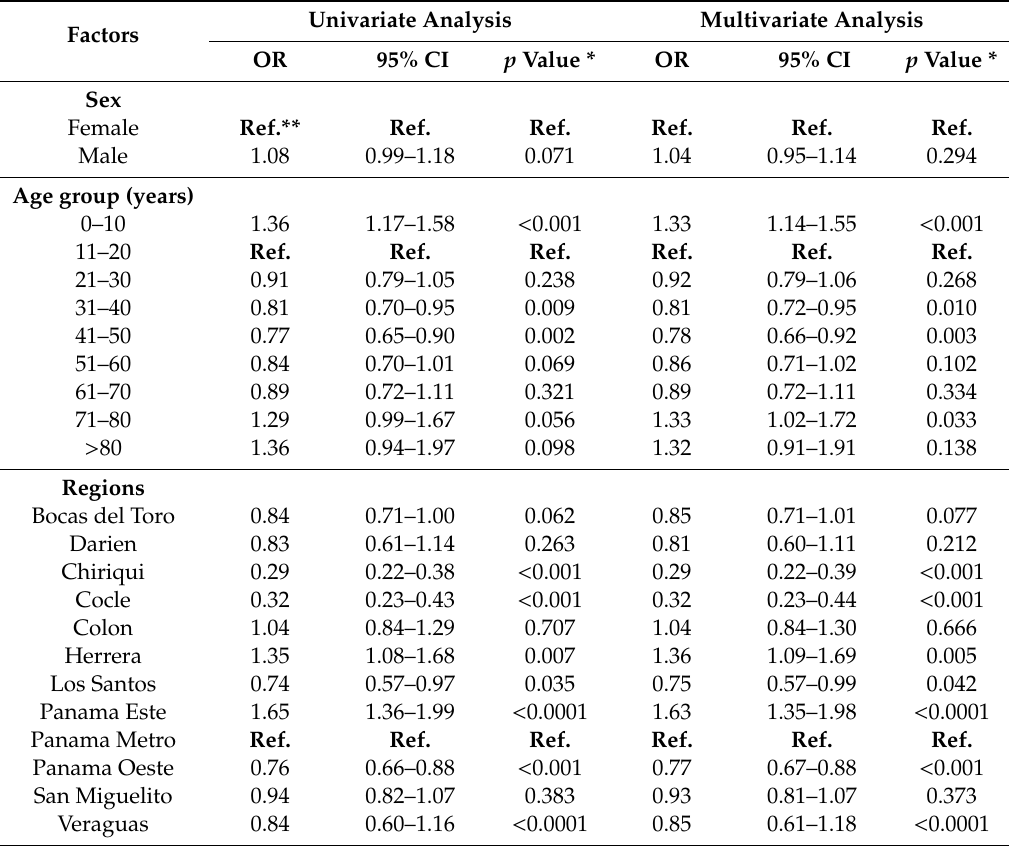
Table 2. Risk factors for dengue hemorrhagic fever in Panama, generalized univariate and multivariate linear